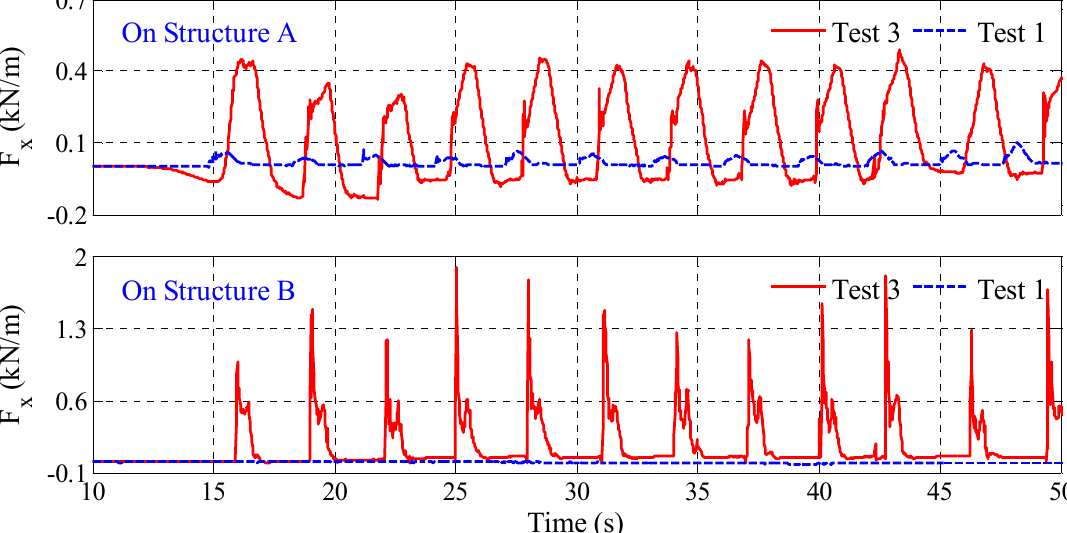
Figure 15. Comparison of wave impact force on structure A and B measured in Test 3 ( d = 0.71 m) and Test 1 ( d = 0.48 m).